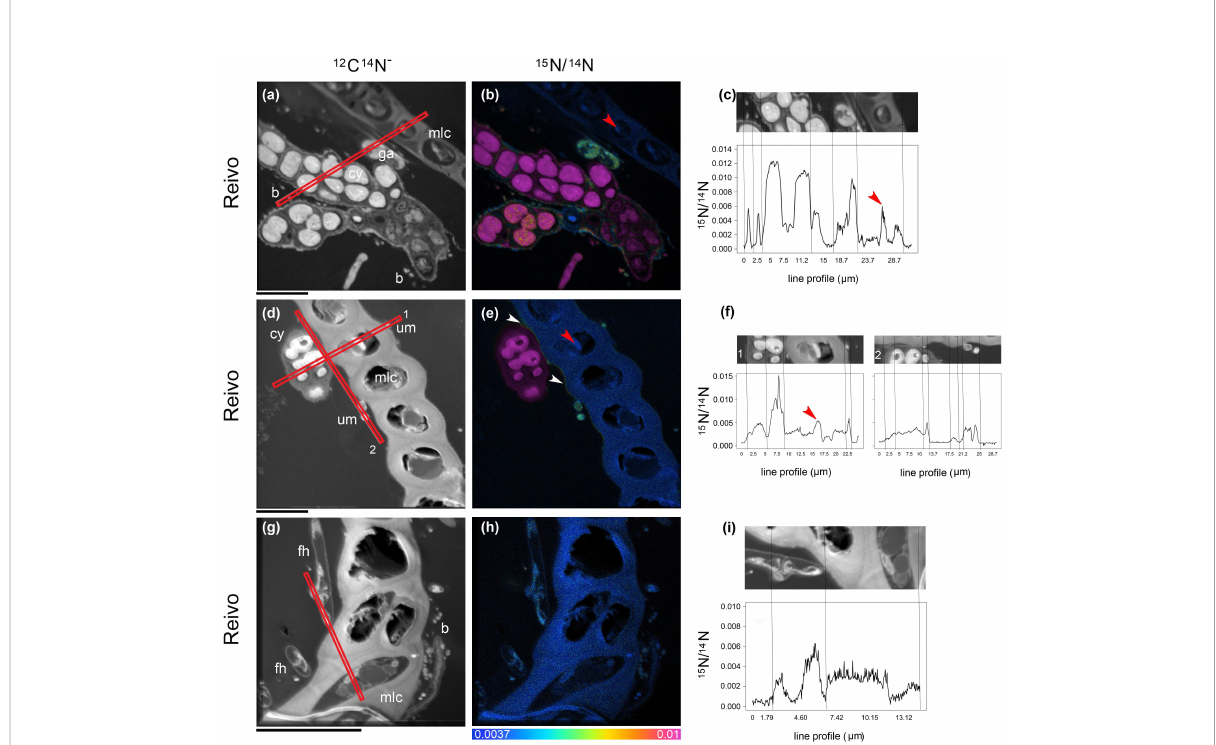
FIGURE 3 Spatial distribution of 15 N accumulation in older brown segments of Pleurozium schreberi shoot and associated microbiome. Enrichment of both moss cells and moss-associated microbiome can be distinguished after one week of continuous exposure to 15 N 2 (a-i). Low 15 N enrichment within the moss cell can be detected in some organelles (red arrow in B, C and E, F ) whereas the cell wall and lipid bodies are not enriched (< 0.0037 15 N/ 14 N, f). Epiphytic bacterial cells in direct contact with cyanobacteria can be seen enriched in 15 N (A – C) ; the uptake of 15 N fi xed by cyanobacteria cells into green algae (A – C) and a hypha from a Basidiomycete (distinguished by a clamp connection at the hyphal septa, white arrows in G – I ) were also detected. In (D – F) an extracellular gradient of 15 N enrichment is visible over the moss cell (indicated by two white arrows). Epiphytic microbes seated on the moss leaf have access to the fi xed 15 N and were enriched (E, F) , whereas the moss cell walls are not enriched (< 0.0037 15 N/ 14 N). Cellular structures are visible in the greyscale 12 C 14 N images (A, D, G), with corresponding 15 N/ 14 N (B, E, H) images re fl ecting levels of 15 N enrichment. The HSI color scale (0.0037 – 0.01; 15 N/ 14 N natural abundance = 0.0037) applies to all